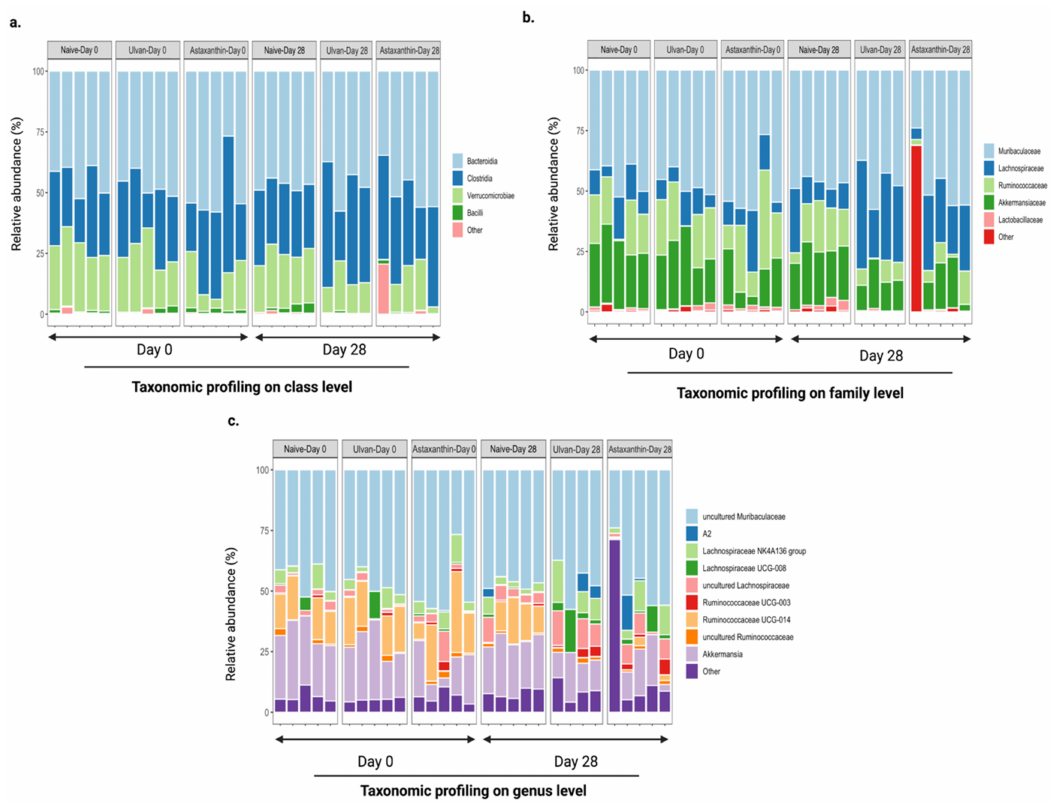
Figure 4. Taxonomic profiles of bacterial communities at class ( a ), family ( b ), and genus ( c ) level of all fecal samples collected from ulvan and astaxanthin-fed mice from Day 0 and Day 28. The bacterial families Muribaculaceae (class Bacteriodia ), Lachnospiraceae (class Clostridia ), Lactobacillaeceae (class Bacilli ), Ruminococcaceae (class Clostridia ), and Akkermansiacaeae